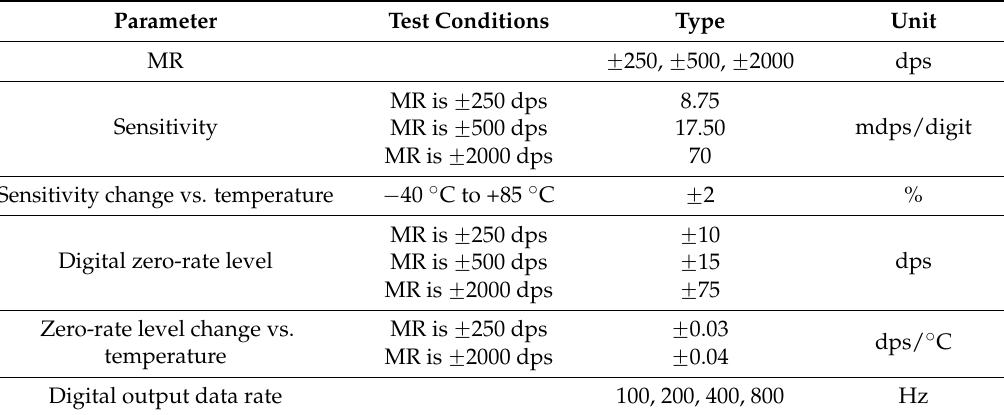
Table 3. Mechanical characteristics of the gyroscope in the iPhone